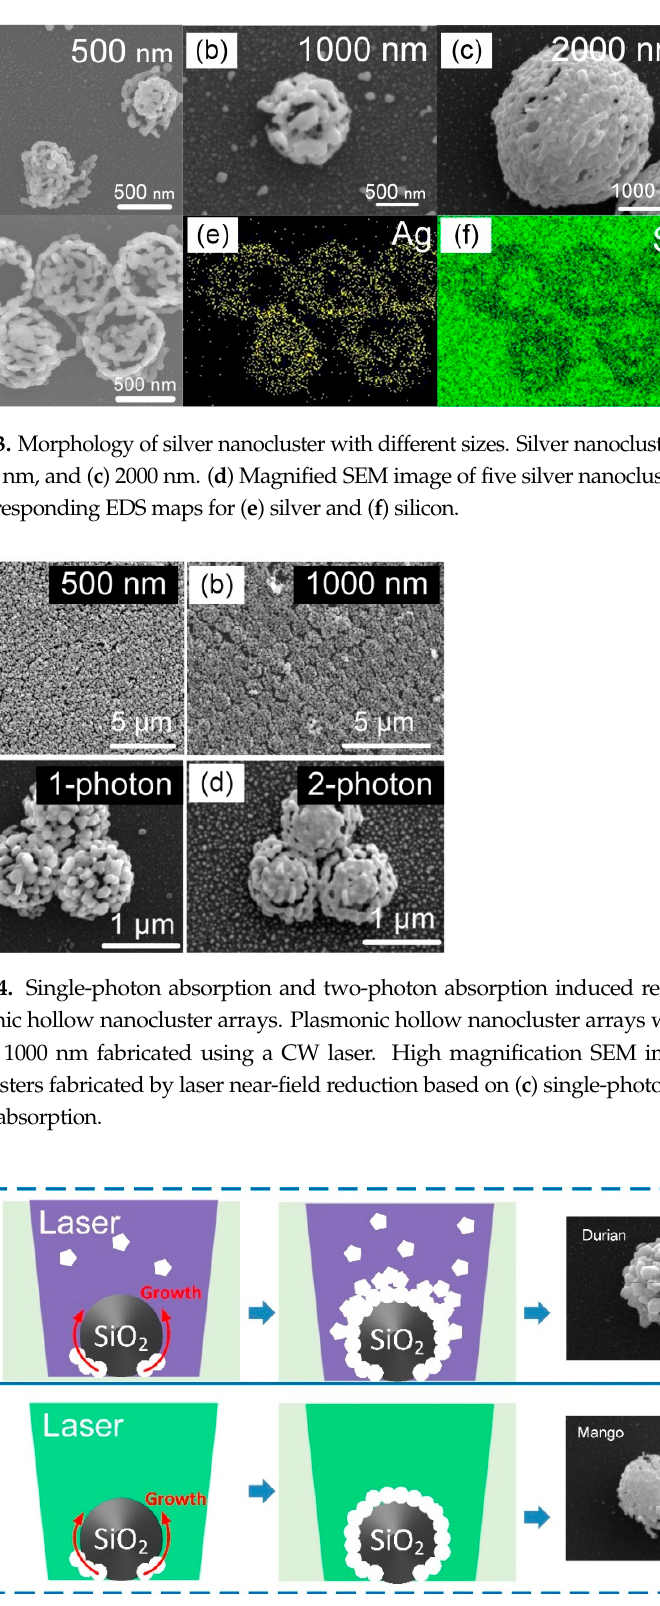
Figure 5. Growth mechanisms of plasmonic hollow nanocluster arrays. Growth mechanisms of plas- monic hollow nanocluster arrays fabricated by laser near-field reduction based on ( a ) single-photon and ( b ) two-photon absorption.